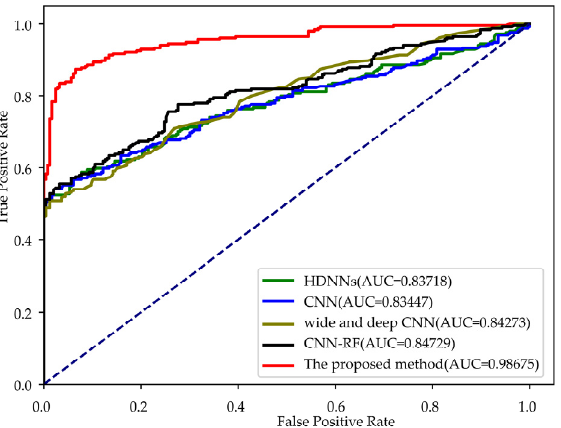
Figure 12. The ROC curves of the method proposed in this paper and the other four methods. Table 7. The methods proposed in this article compare the results with other methods. Methods